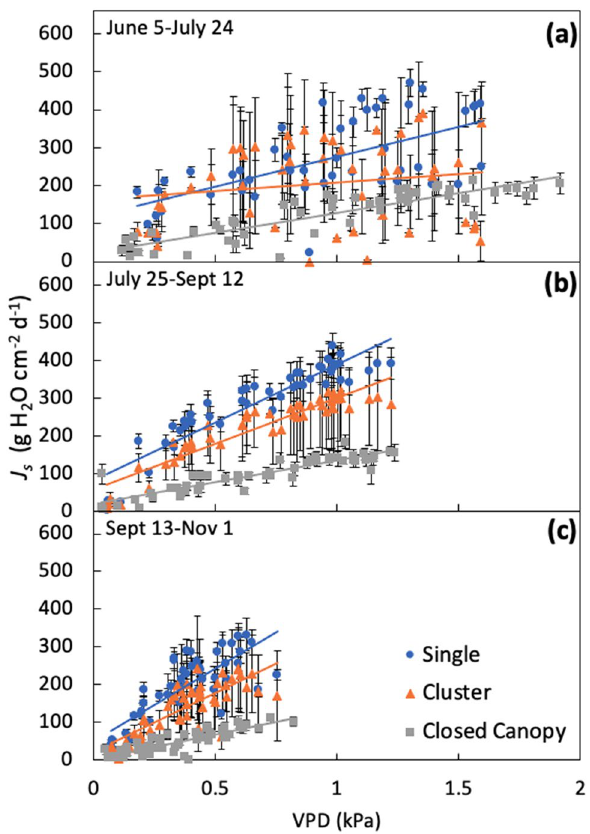
Figure 4. Mean daily sum of sap flux density ( J S ) as a function of VPD during early summer ( a ), late summer ( b ), and fall ( c ). Values are mean ±